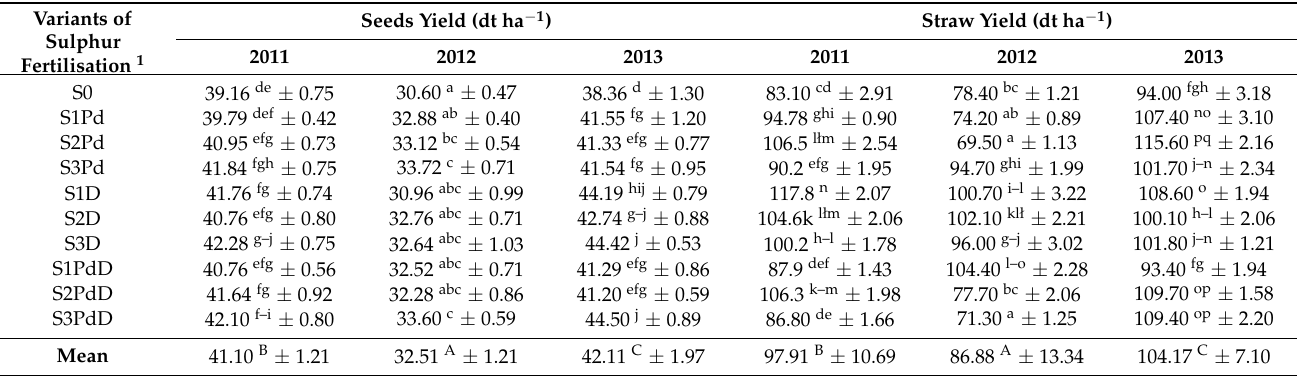
Table 5. The influence of variants of sulphur fertilisation on the yield of seeds and straw of winter